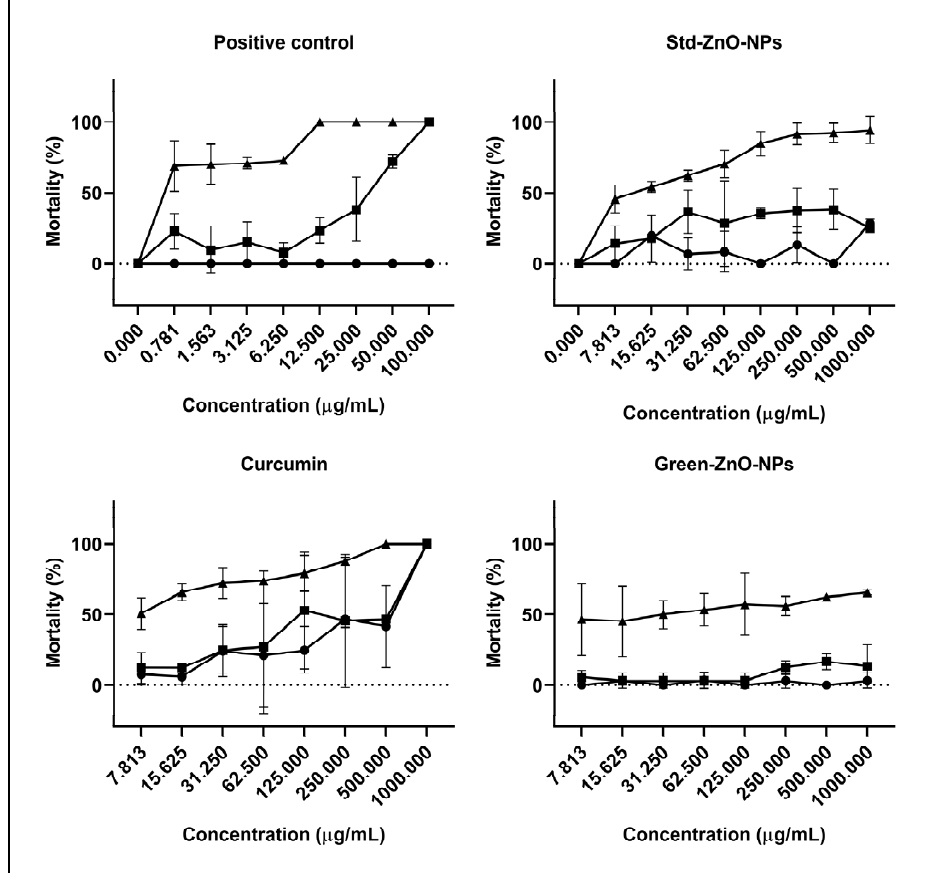
Figure 10. Mortality rates of Artemia larvae treated with potassium dichromate (positive control), Std ‐ ZnO ‐ NPs, Green ‐ ZnO ‐ NPs and curcumin at various concentrations after 4 ( ), 8 ( ), and 24 h ( ). with Green ‐ ZnO ‐ NPs, Std ‐ ZnO ‐ NPs and curcumin. Both Green ‐ ZnO ‐ NPs and Std ‐ ZnO ‐ NPs aggregated inside the gut of Artemia larvae, as clearly observed in Figure 11 (red ar ‐ row). Artemia larvae have a nonselective filter ‐ feeding behaviour, and it consumes